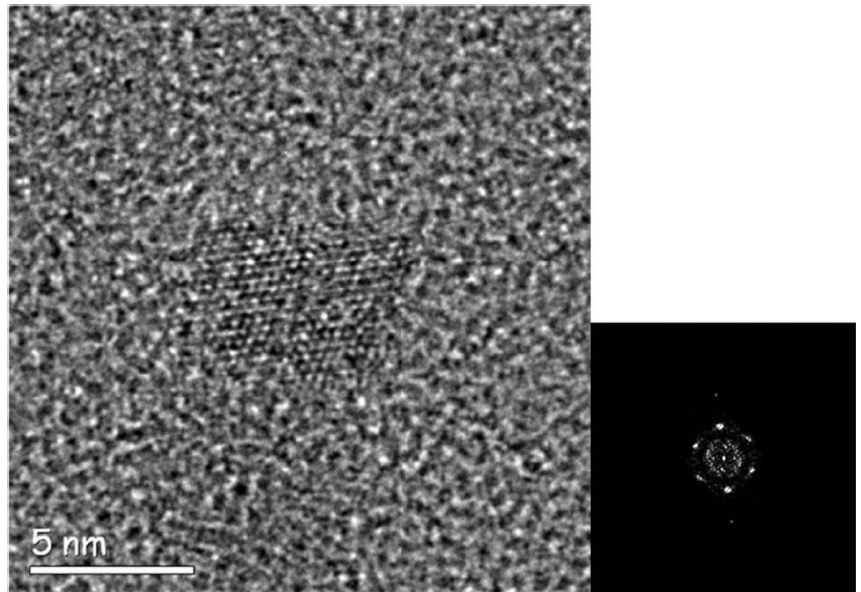
Figure 6. Left: Low dose rate HRTEM of a particle of vincamine. Right: the relevant high symmetry di ff ractogram. The lattice fringes in the central part of the particle and the spot splitting in the di ff ractogram point the presence of an extended structural defect in the crystal structure (reprinted by courtesy from Hasa et al. [4]) .